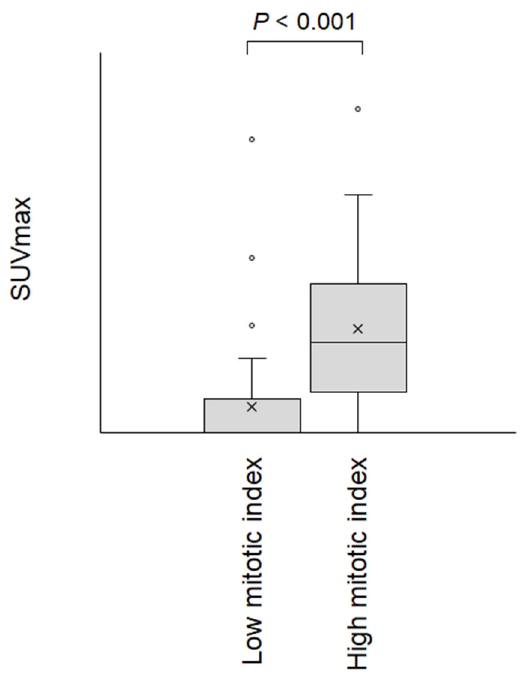
Figure 4. Dot-plot diagram showing the SUVmax of gastrointestinal stromal tumors with a low mitotic index ( ≤ 5 mitoses / 50 high-power fields) and a high mitotic index ( ≥ 6 mitoses / 50 high-power fields).